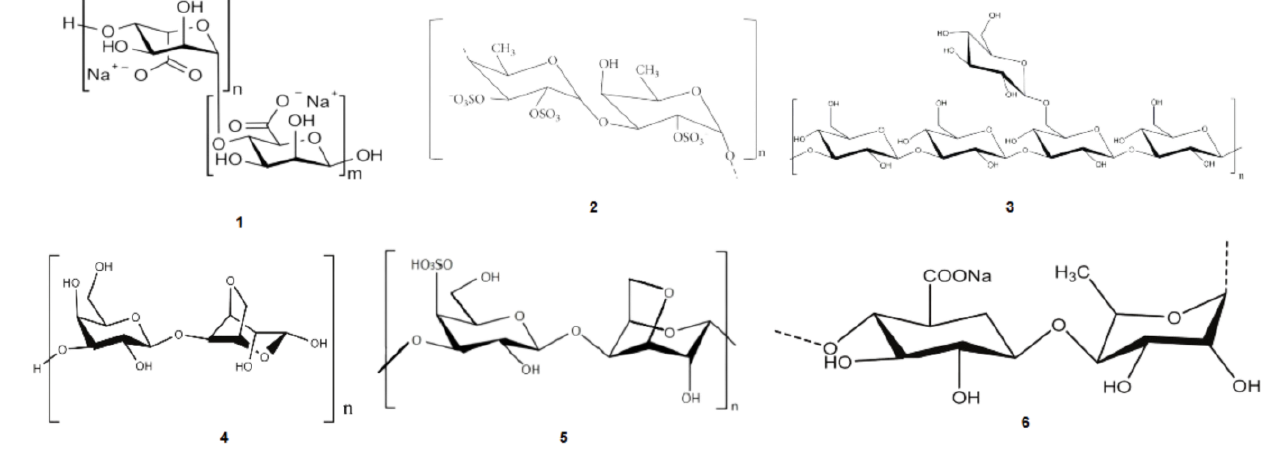
Figure 1. Polysaccharides from macroalgae.